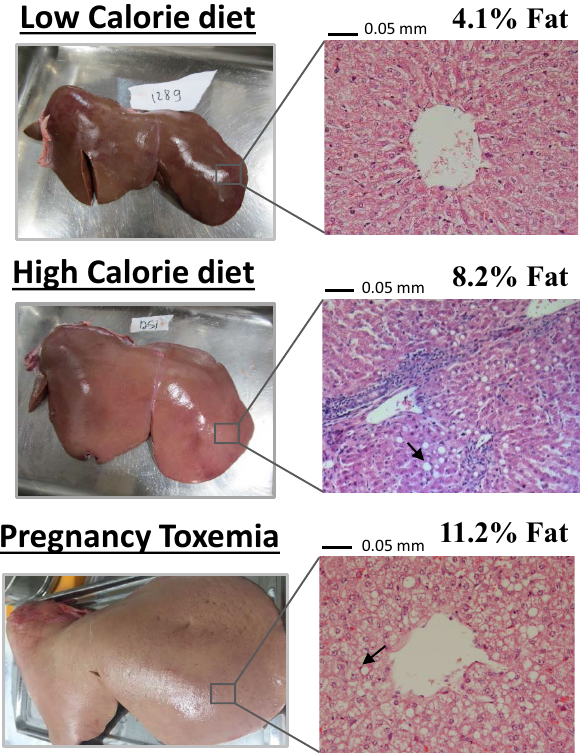
Figure 5. Representative pictures of livers and corresponding histopathological analysis. Liver sections were stained by H&E and imaged at ×200 magnification. The arrows exemplify macrovesicular steatosis where hepatocytes nuclei are pushed aside by large lipid